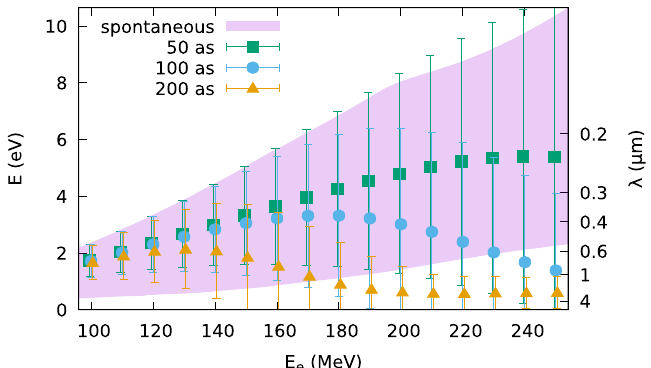
Figure 2. Mean photon energy E and r.m.s. bandwidth (error bars) of coherent undulator radiation produced by electron beams with energy E e between 100 and 250 MeV, 0.1% uncorrelated energy spread, 0.05 mrad divergence, 1 π mm mrad normalized emittance and r.m.s. bunch duration of 50 as, 100 as and 200 as. Radiation is observed 1 m from the undulator exit in a 40mm × 40 mm area and integrated between 0.1 and 6 eV ( 100 MeV ≤ E e ≤ 150 MeV ), 10 eV ( 160 MeV ≤ E e ≤ 200 MeV ) or 15 eV ( 210 MeV ≤ E e ≤ 250 MeV ). The shaded area marks the r.m.s bandwidth σ E of spontaneous emission. Simulations carried out using